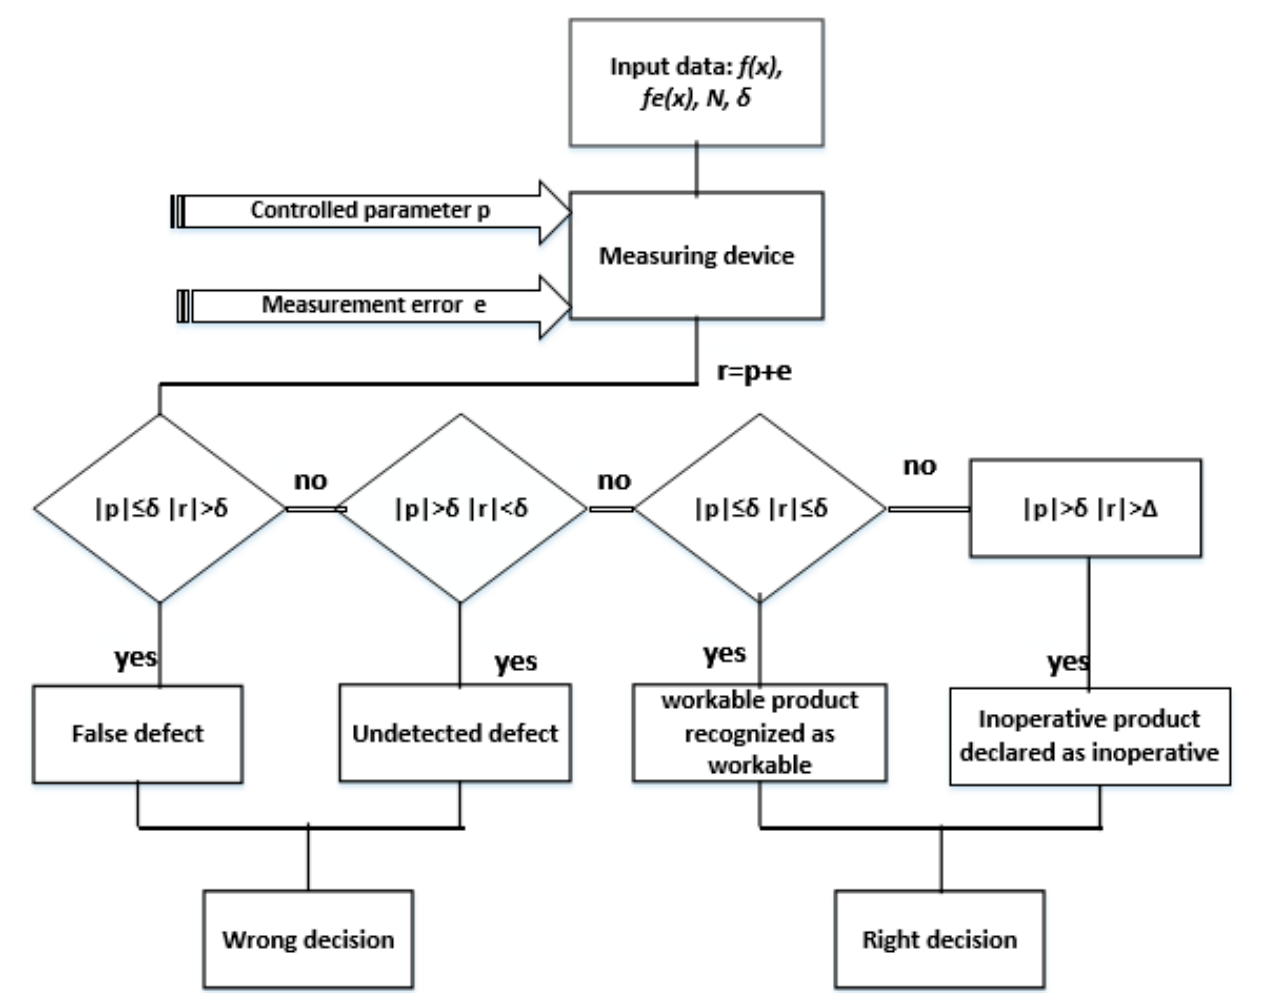
Figure 3. General scheme of diagnostics and decision-making based on the tolerance control method.